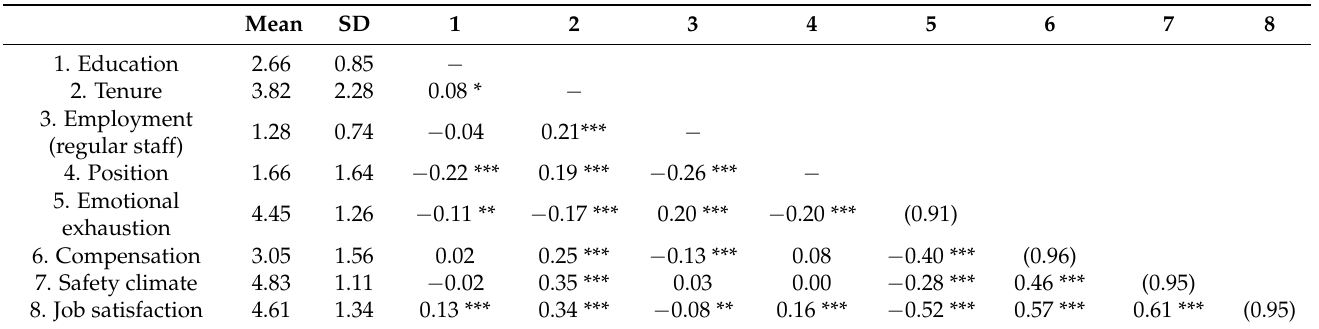
Table 2. Descriptive statistics and inter-correlations.